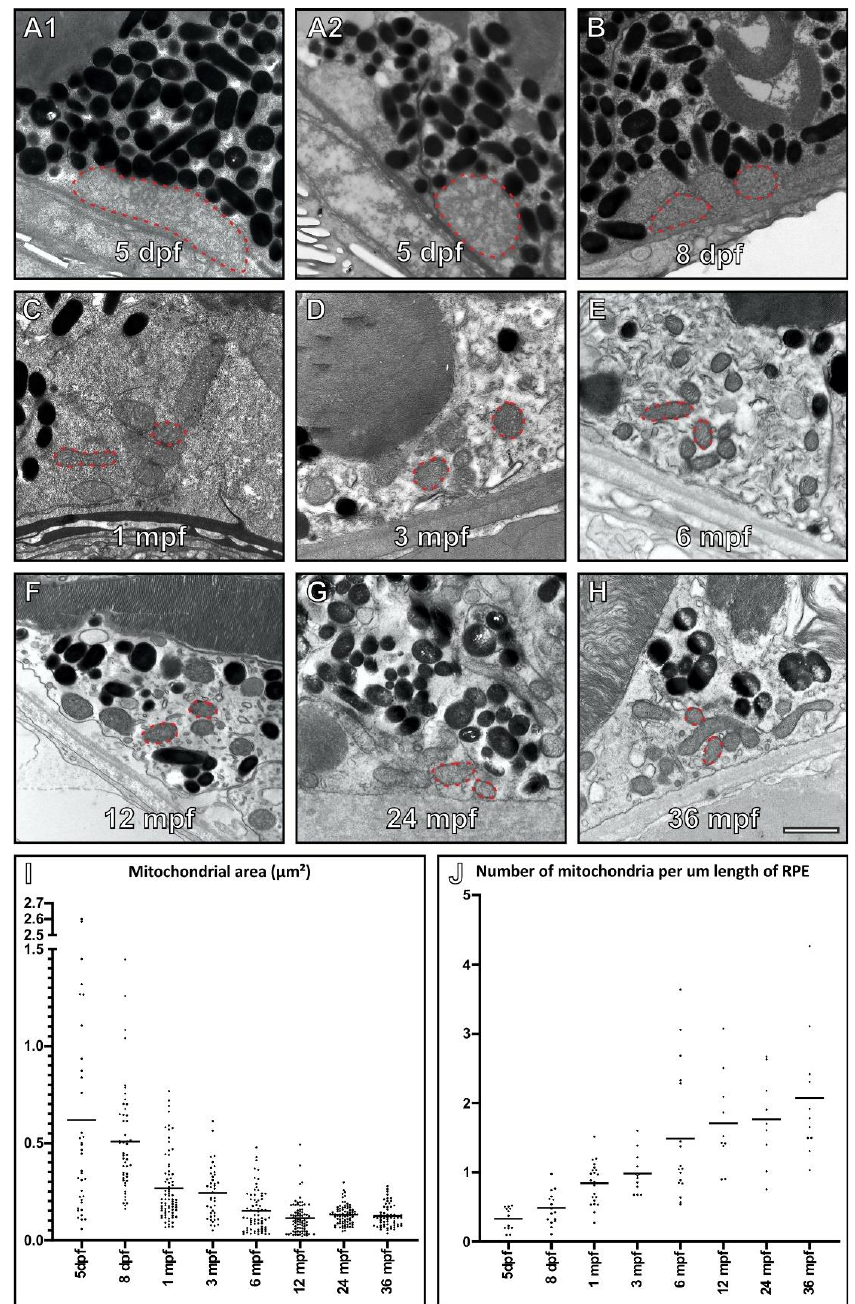
Figure 1. Mitochondria increase in number and decrease in size within the retinal pigment epithelium (RPE) of ageing zebrafish retina. ( A – H ) Electron microscopy images of mitochondria within zebrafish RPE at 5 dpf through to 36 mpf. The red dotted lines indicate examples of mitochondria within the RPE at each timepoint. All mitochondria were measured in random areas of RPE. When individual mitochondria are examined within the RPE, they ( I ) decrease in size and ( J ) increase in number as the zebrafish age. ( I , J ) At each timepoint, n = 3 zebrafish were examined, and measurements taken from ( I ) ≥ 34 mitochondria per age group and ( J ) ≥ 8 regions of the RPE. Statistical significance determined by one way-ANOVA ( I – J ) with p < 0.0001. Scale ( A – G ) 1 µm.